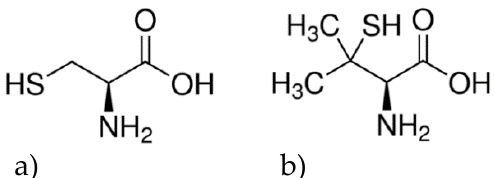
Figure 1. The molecular structures of ( a ) L-Cys and ( b ) L-Pen differ only in the addition of two methyl groups to the terminal carbon.